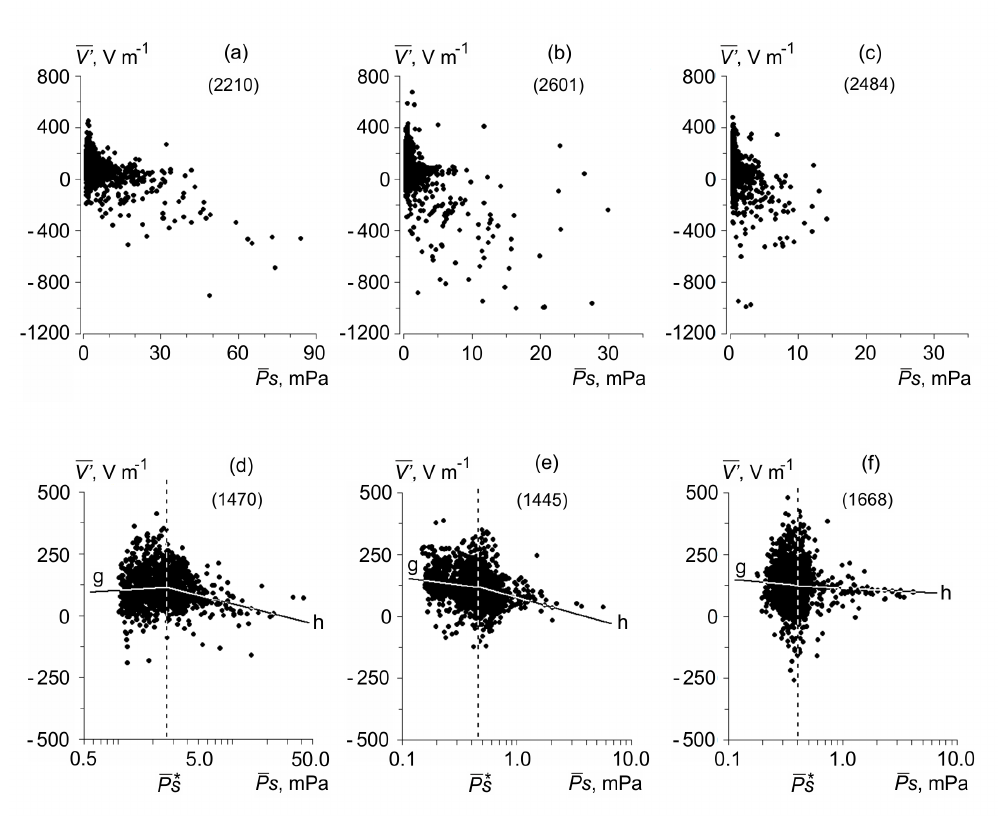
Figure 6. Scatterplots between the average hourly values of acoustic pressure and atmospheric electric field potential gradient V (cid:48) in the experiment 2006 ( a ), 2007 ( b ), 2008 ( c ) and for the same experiments during calm weather conditions ( d – f ), respectively. The number of P s and V (cid:48) pairs is shown in brackets. Vertical dashed lines are P ∗ s values which correspond to the discontinuity points of the piecewise linear regression on P s ; g, h are the lines illustrating the regression for background and tectonic components of the relation between P s and V (cid:48) .